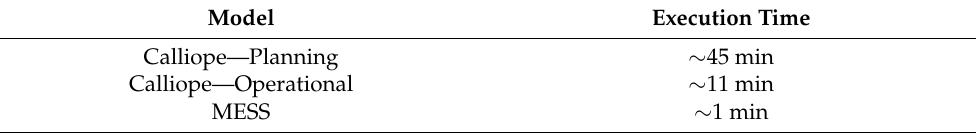
Table 3. Comparison of the execution times for the three